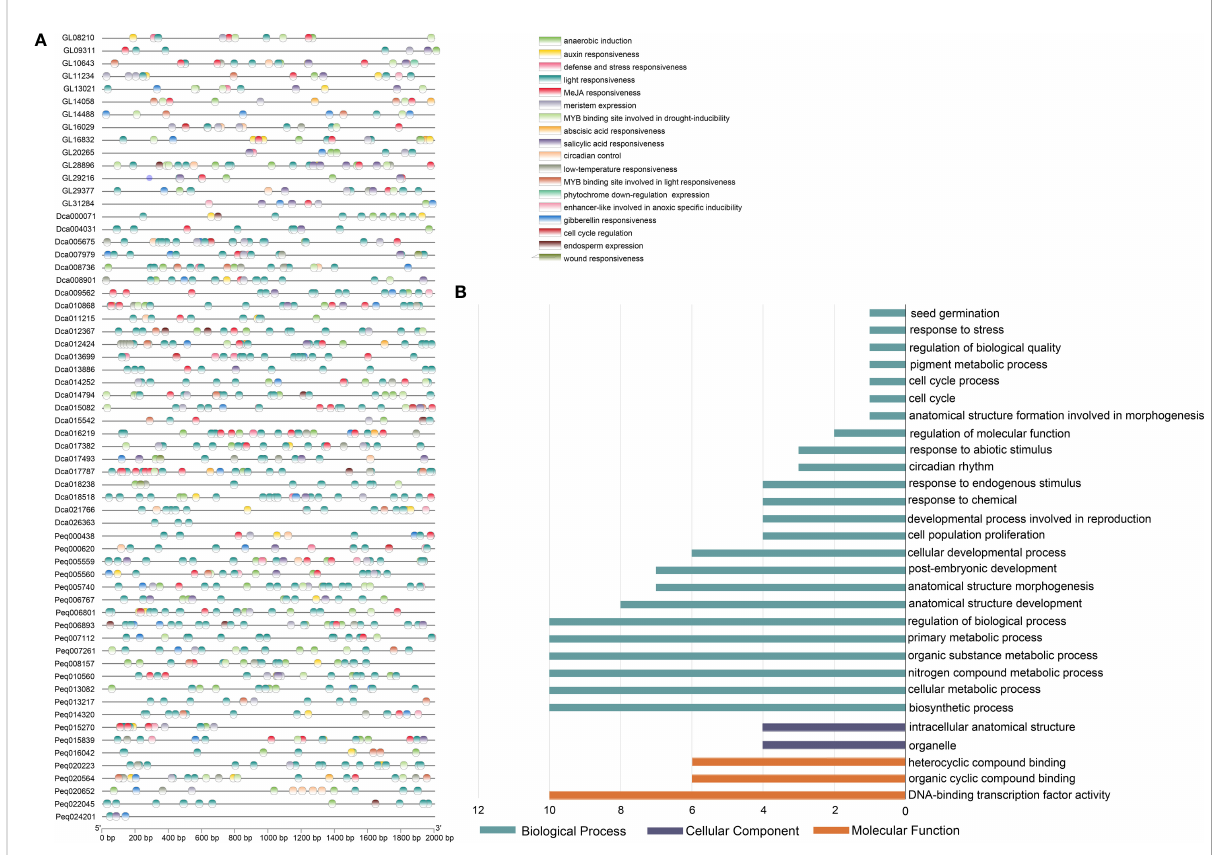
FIGURE 5 Cis -acting elements and GO enrichment analysis in the promoter regions of TCP genes. (A) Elements analysis of C. goeringii , P. equestris and D . catenatum , the same regulatory functions are presented in the same color. (B) Gene Ontology (GO) terms of C goeringii TCP genes; the detailed data are listed in Supplementary Table